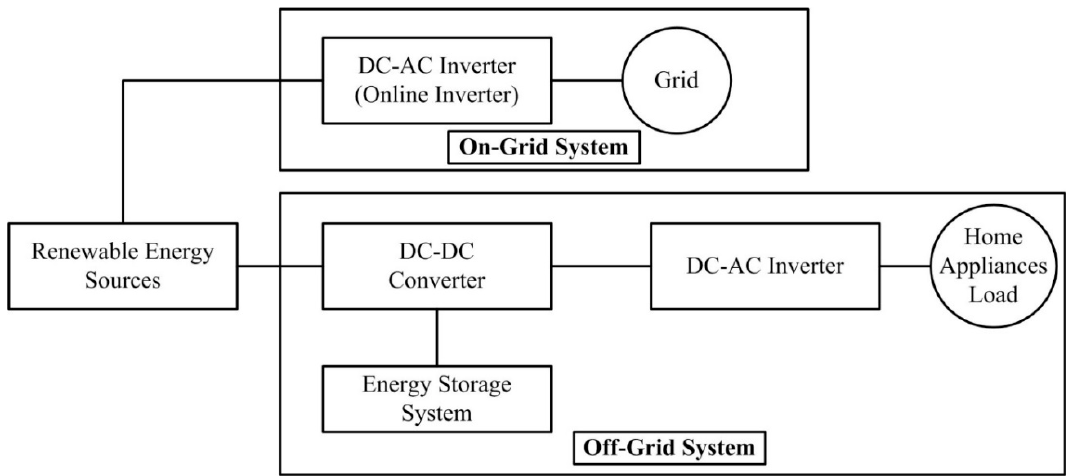
Figure 1. Renewable energy source on and off grid system.